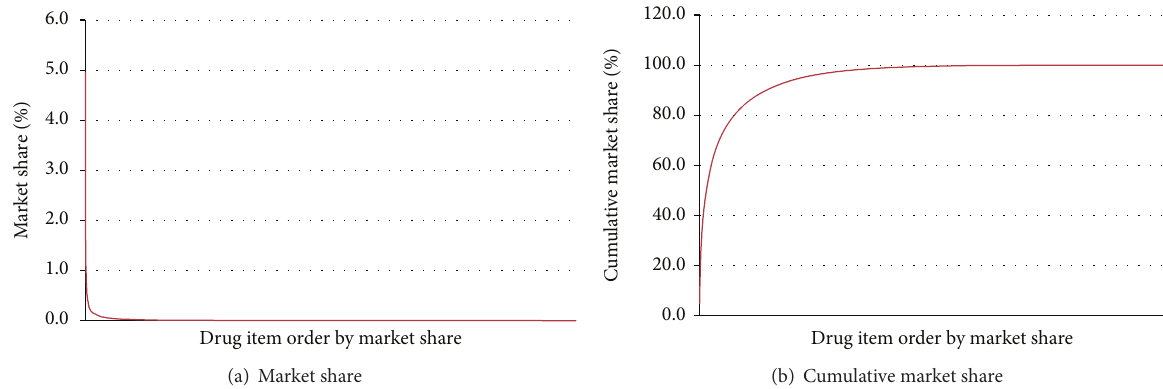
Figure 2: Market share of oral pills (tablets and capsules) prescribed within Taiwan’s National Health Insurance in 2007. (a) Market share. (b) Cumulative market